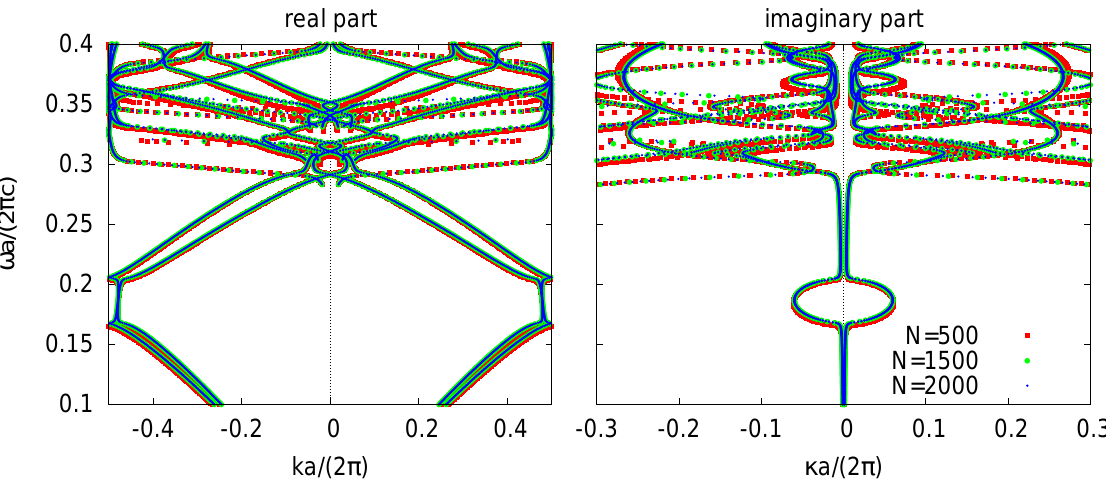
Figure 9. Well-behaved convergence for the photonic crystal based on the Kelvin